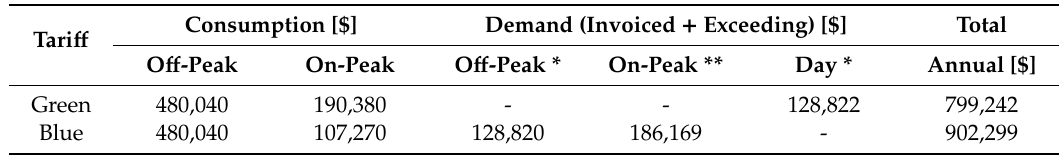
Table 7. Main results for Scenario 3.